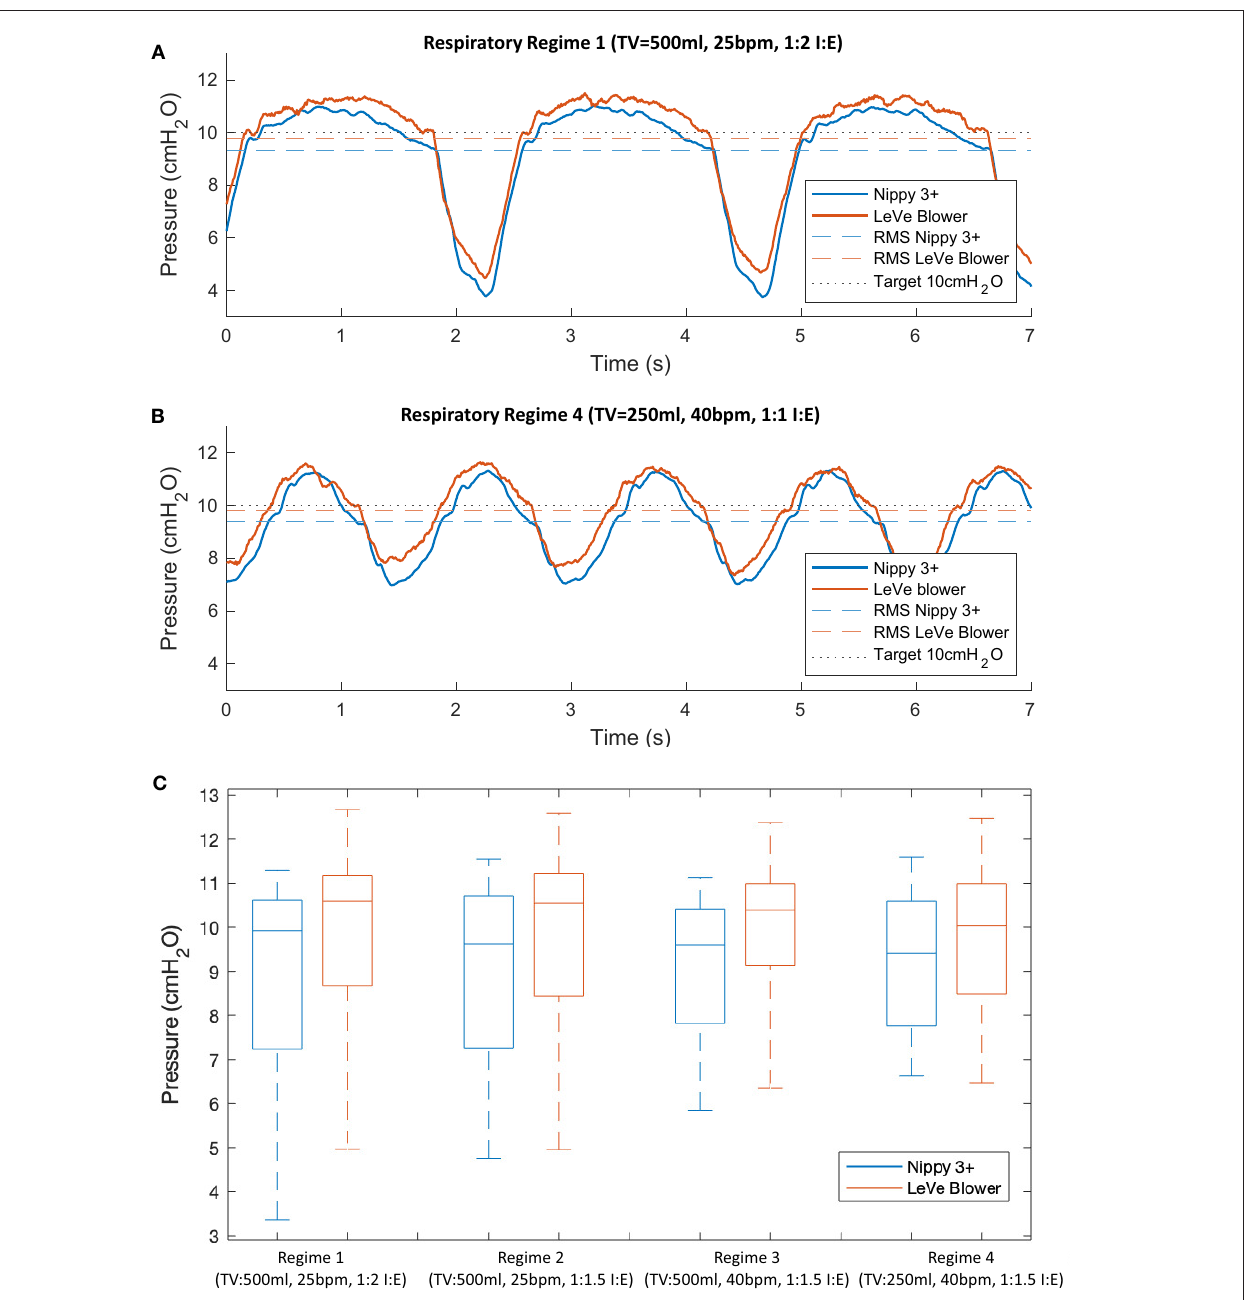
FIGURE 6 | Typical pressure response characteristics of the LeVe system and a commercial sleep apnea CPAP system (Nippy 3 + ), configured to generate 10cm H 2 O (Indicated by black dotted line) shown for different respiratory regimes, defined by Tidal Volume (TV), Breaths per Minute (BPM), and Inspiration:Expiration ratio (I:E). Parts (A,B) show representative pressure waveforms for two contrasting respiratory regimes, (C) provides a boxplot summary of the pressure characteristics across all respiratory regimes defined in Table 1